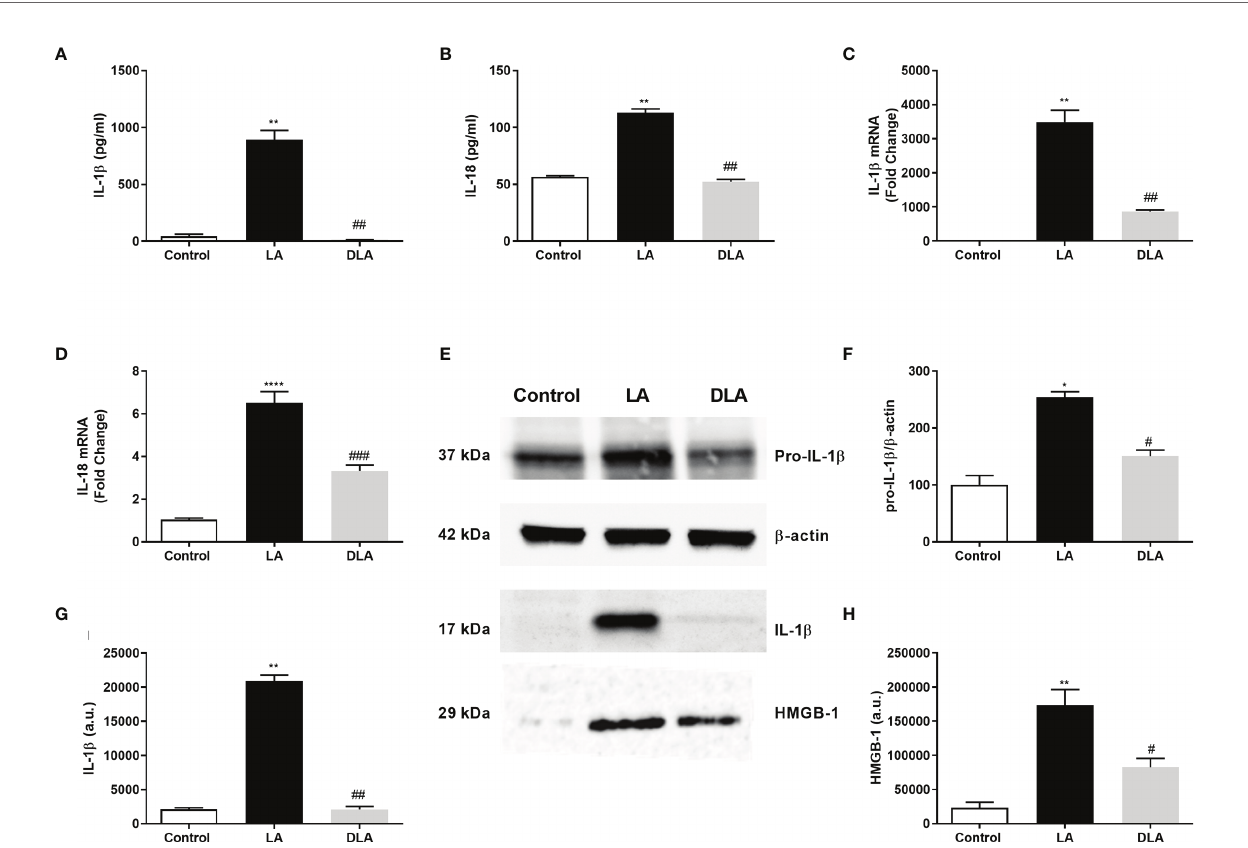
FIGURE 1 | DMF suppressed in fl ammasome-induced secretion of pro-in fl ammatory cytokines and HMGB-1. N9 microglia were pretreated with DMF (10 µM) for 1hour, primed with UP-LPS (1000 ng/ml) for 4 hours, and followed by ATP (5 mM) for 1 hour. (A, B) Pretreatment with DMF decreased the protein and mRNA levels of IL-1 b , IL-18, and HMGB-1. The protein levels of IL-1 b , IL-18 were evaluated with ELISA. (C, D) mRNA levels of IL-1 b and IL-18 were detected with qRT-PCR. (E – H) The expression of pro-IL-1 b , IL-18, and their secretion along with HMGB-1 in supernatants were assessed by Western blot. Data are presented as mean ± S.E.M, n = 5. *p < 0.05, **p < 0.01, ****p<0,0001 compared to control and # p < 0.05, ## p < 0.01, ### p<0,001 compared to LPS and ATP induced